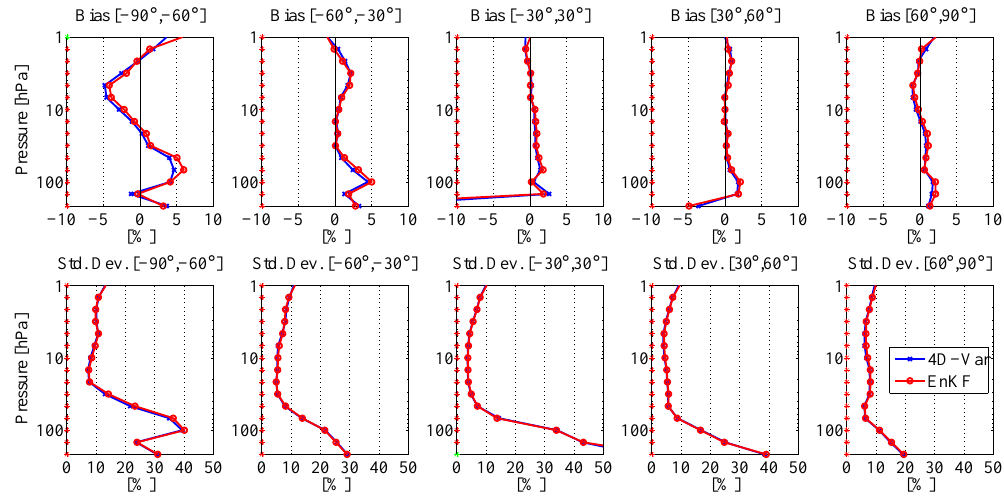
[ (cid:97) =0.025, r=1.65] [ (cid:97) =0.025, r=1] [ (cid:97) =0, r=1] Fig. 3: OmF statistics, bias and standard deviation, with respect to the MLS data of the EnKF experiments using [ α = 0 , r = 1] (orange dashed line), [ α = 0 . 025 , r = 1] (green dashed), and [ α = 0 . 025 , r = 1 . 65] (red solid). for the